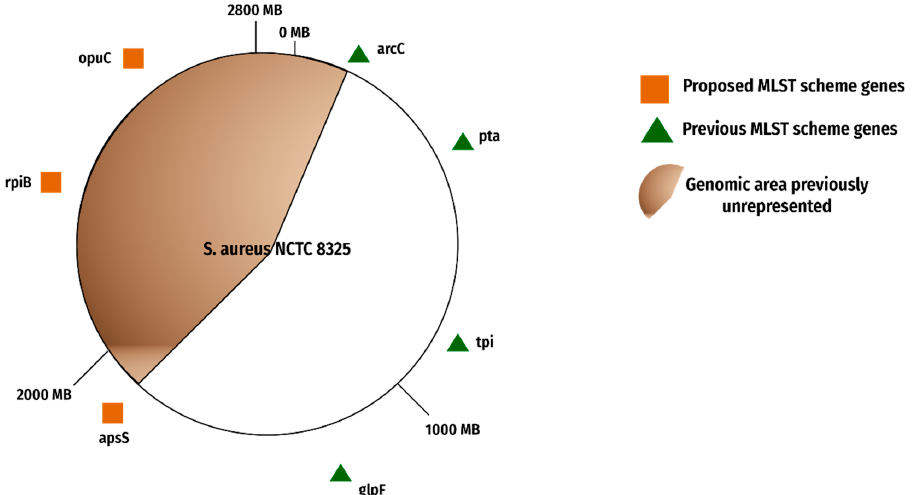
vious MLST scheme. Afterward, the genome map was modified in the form of Figure 7.